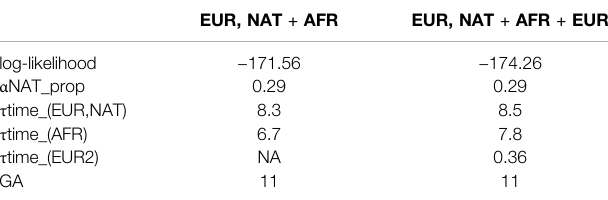
TABLE 1 | Two migration models were tested. 1) EUR, NAT + AFR is a simple model were NAT has fi rst contact with EUR in time T_1, with a subsequent pulse of AFR migration in T_2; 2) EUR, NAT + AFR + EUR is model with a fi rst NAT and EUR contact at time T_1, followed by an AFR pulse at T_2 and with a subsequentEURpulseatT_3.Log-likelihoodofeachmodelisgiven.TRACTS estimates the generations (in GA units) of the fi rst NAT-EUR contact, which is given under GA.